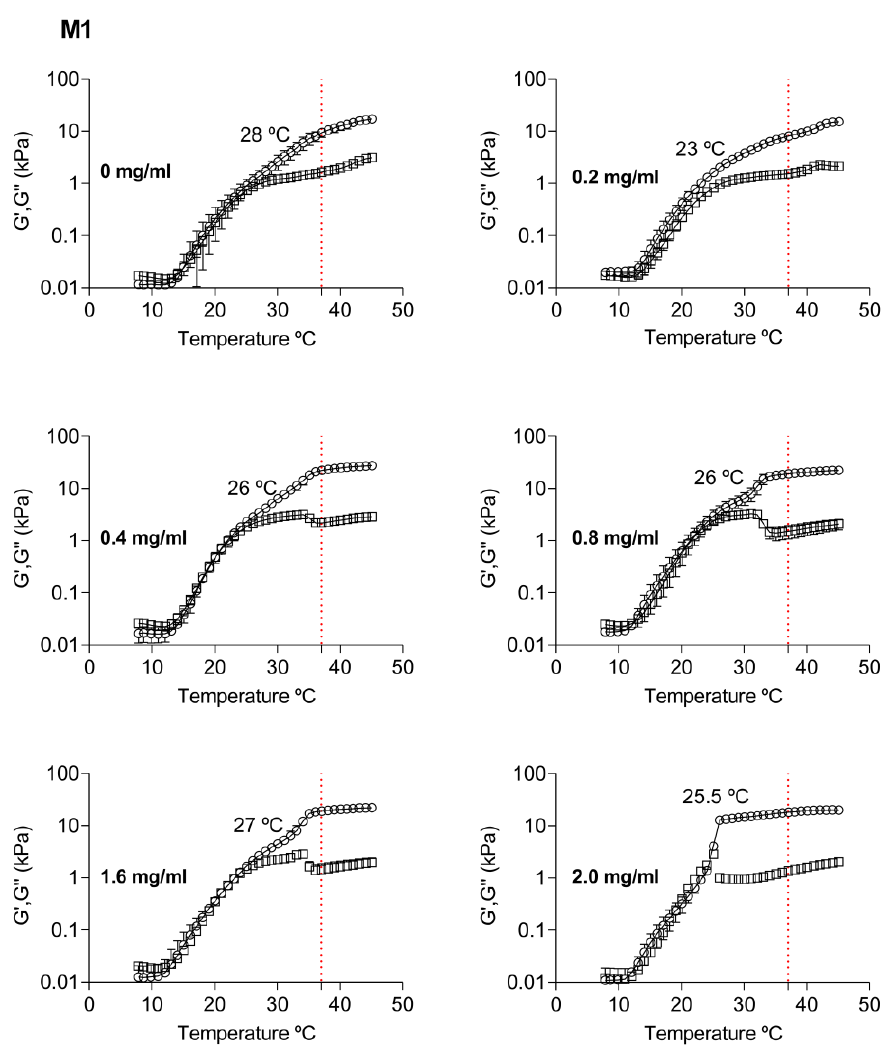
Figure 6. Rheological behavior of P407 18% Casein 10% hydrogel at different concentrations of the TBH-PCL nanoparticles which were added to the final P407 18% Casein 10% hydrogel (M1). Data are average ± SD (n = 4). In the vertical axis, the red dotted line refers to 37 °C, ( ○ ) storage modulus, and ( □ ) loss modulus.